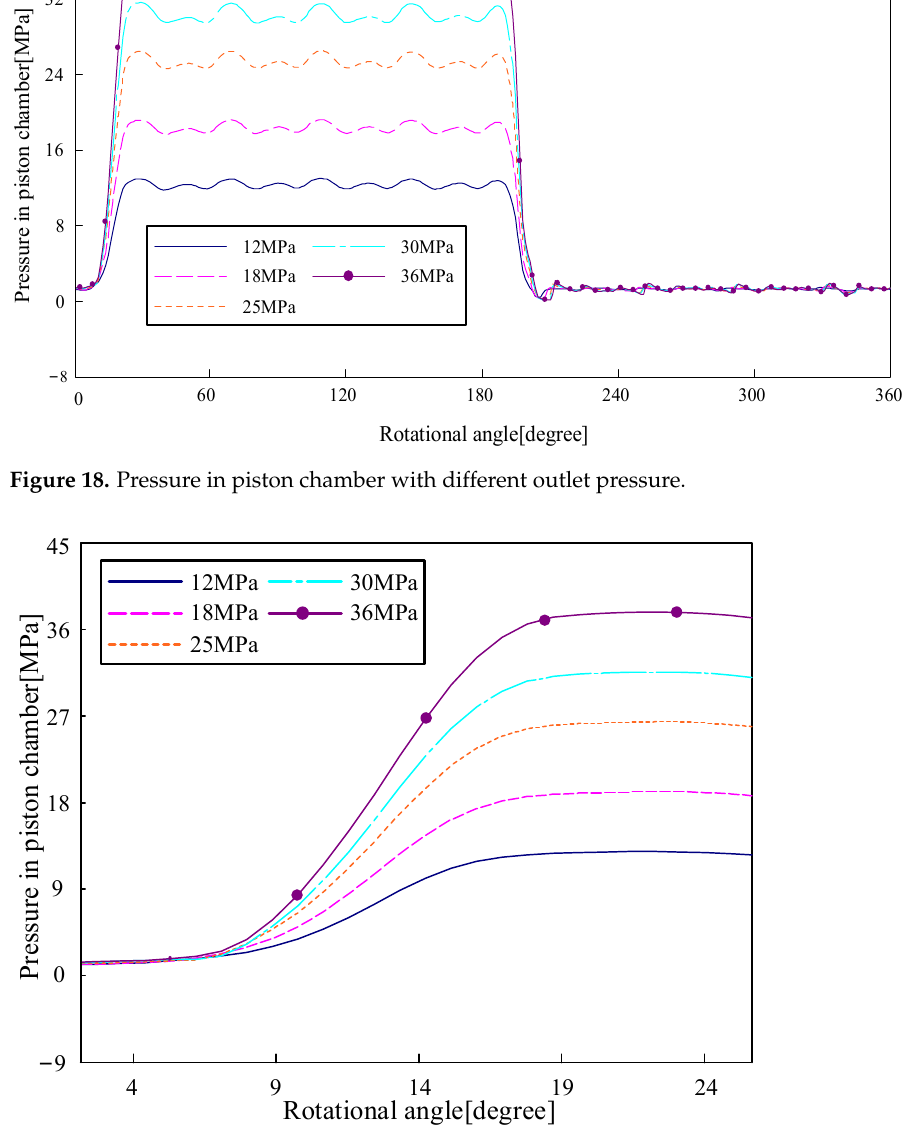
Figure 19. Pressure in the piston chamber with different outlet pressure at the beginning of the discharge phase.